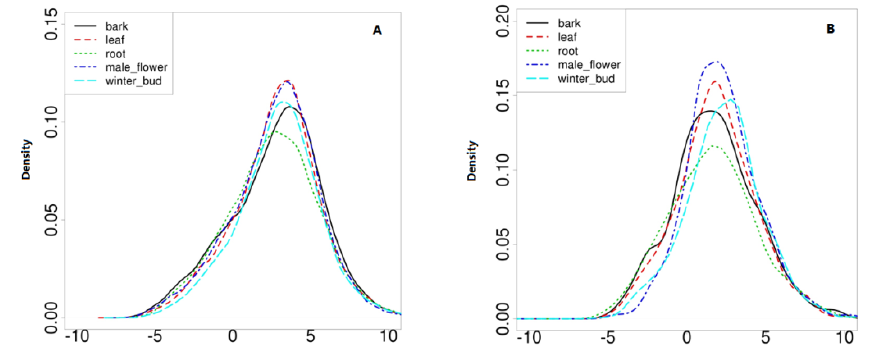
Figure 5. Sequence features of lncRNAs. ( A ) and ( B ) represented the length distributions of the transcripts from novel lncRNAs ( A ) and known coding genes ( B ); (C) and (D) represented the exon numbers of the transcripts of lncRNAs ( C ) and known coding genes ( D ).